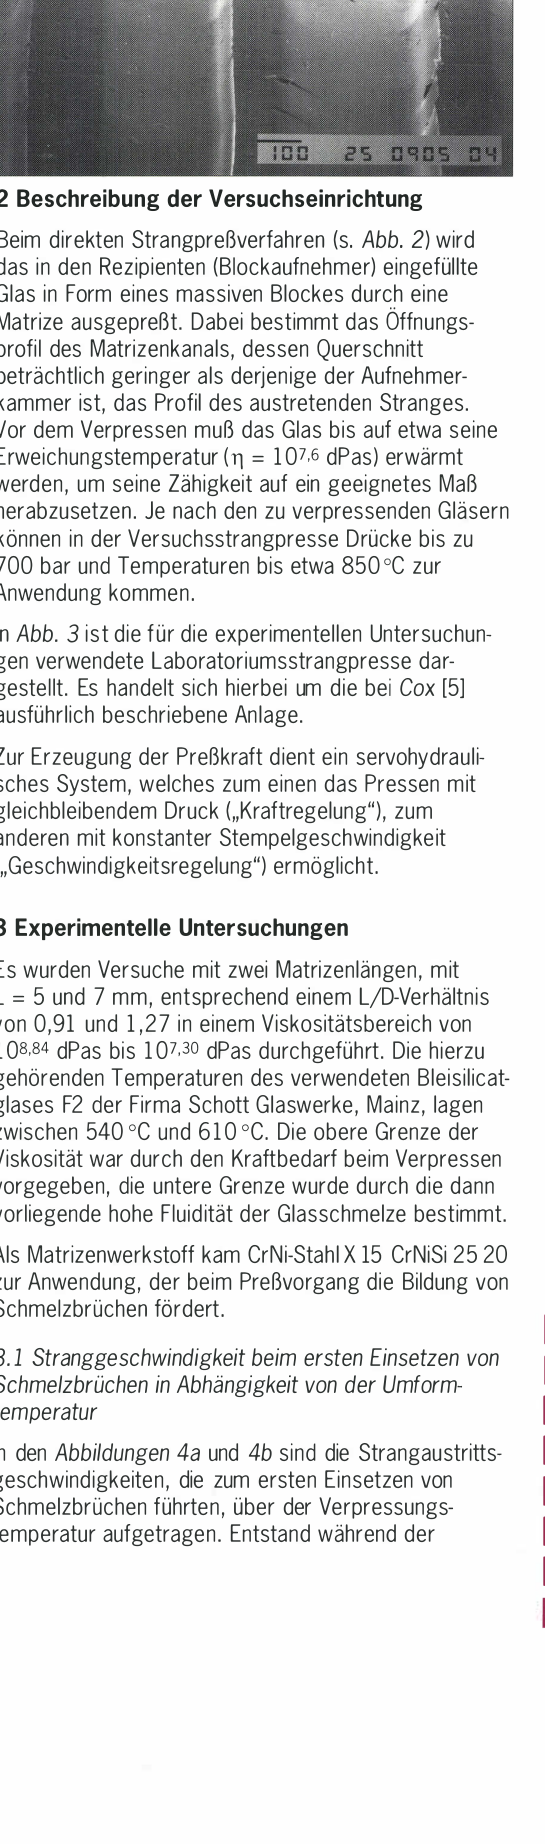
Fig. 1: Melt fracture during